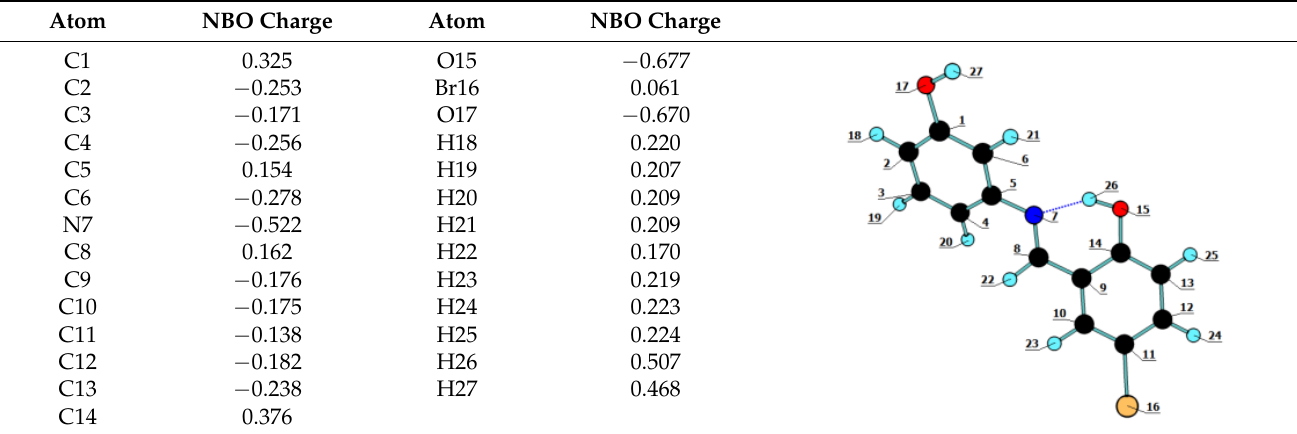
Table 5. DFT(B3LYP)/6-311++G(d,p) NBO atomic charges (in units of electron; e = 1.60217646 × 10 − 19 C) for the E -enol-imine V conformer.